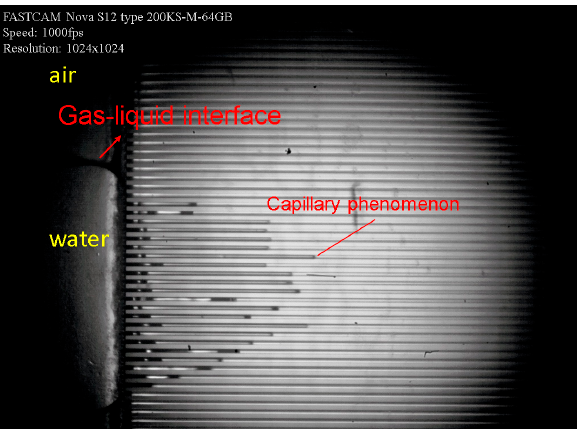
Figure 11. Capillary suction image: The left part of the image is the cavity at the entrance of the microchannel array, from which the liquid flows into the microchannel. The gas-liquid interface can be clearly seen in the figure. The middle part of the image is capillary phenomenon.